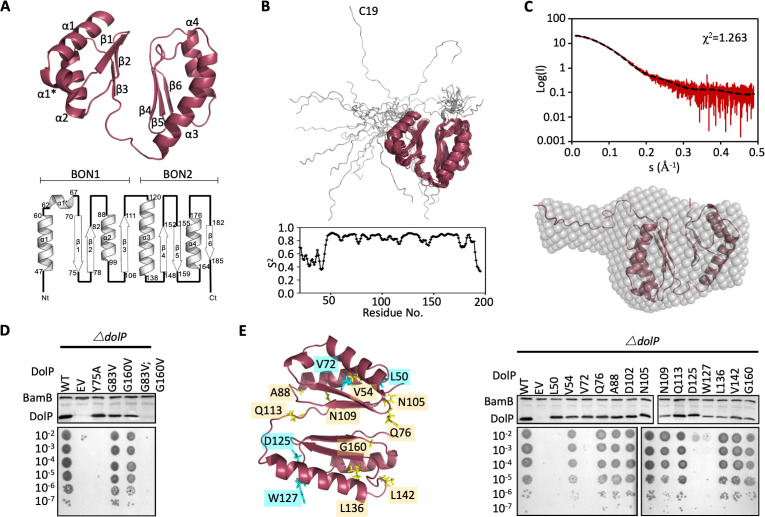
Structure of DolP.(A) Solution structure and topology of DolP, with α helices, β strands and termini labelled. (B) Backbone model of the 20 lowest-energy solution structures of DolP. The core folded domain is highlighted in red whilst the flexible N-terminal is shown in grey. The dynamic nature of the linker was demonstrated from S2 order parameter analysis calculated from chemical shift assignments using TALOS+. (C) Small-angle X-ray scattering curve of DolP with corresponding best fit of the solution structure of DolP. Best fit calculated based on the core DolP solution structure with flexibility accommodated in residues 20–46, 112–118, and 189–195. The corresponding ab-initio bead model is shown calculated using Dammif (Franke and Svergun, 2009) based solely on the scattering data. (D) Western blots of total protein extracts show plasmid-mediated expression of DolP in E. coli ΔdolP after site-directed mutation of conserved residues. The empty vector (EV) control is labelled and WT represents wild-type DolP. The presence of the OM lipoprotein BamB was used as a control. Colony growth assays by serial dilution of mutants on 4.8% SDS reveal which residues are critical for the maintenance of the OM barrier function. (E) Structure of DolP showing position of transposon-mediated insertions. Western blots of total protein extracts show plasmid-mediated expression of mutant versions of DolP in E. coli ΔdolP. The empty vector (EV) control is labelled and WT represents wild-type DolP. Colony growth assays by serial dilution of mutants on 4.8% SDS reveal which insertions abolish DolP function. Blue labels represent position of non-functional insertions. Orange labels represent position of tolerated insertions. The presence of the OM lipoprotein BamB was used as a control.Figure 2—source data 1.Influence of site directed mutagenesis of DolP of protein production and stability.Figure 2—source data 2.S2 order parameter analysis.